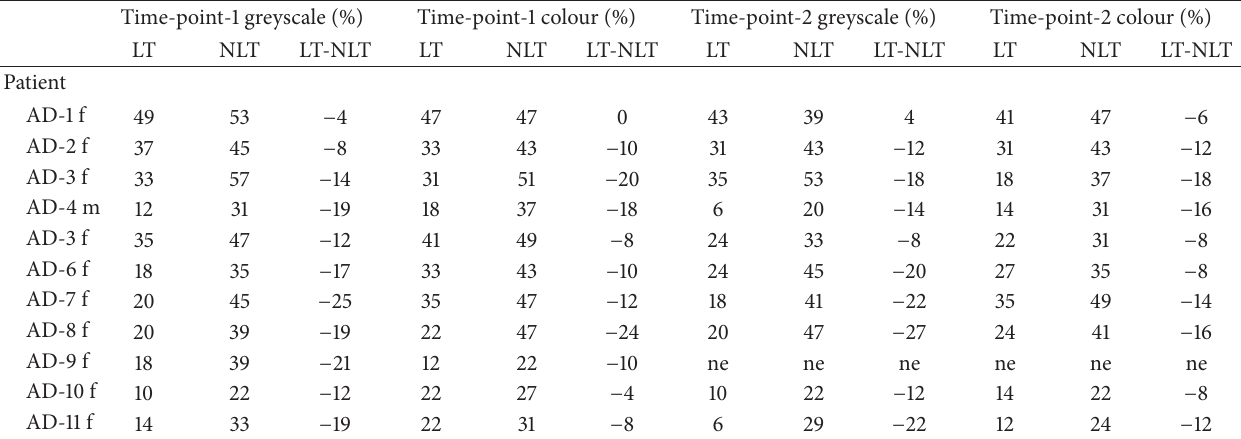
Table 5: Individual mean naming performance (percentage of correct responses) of AD patients according to domain (LT/NLT), format (colour/greyscale), and moment of evaluation